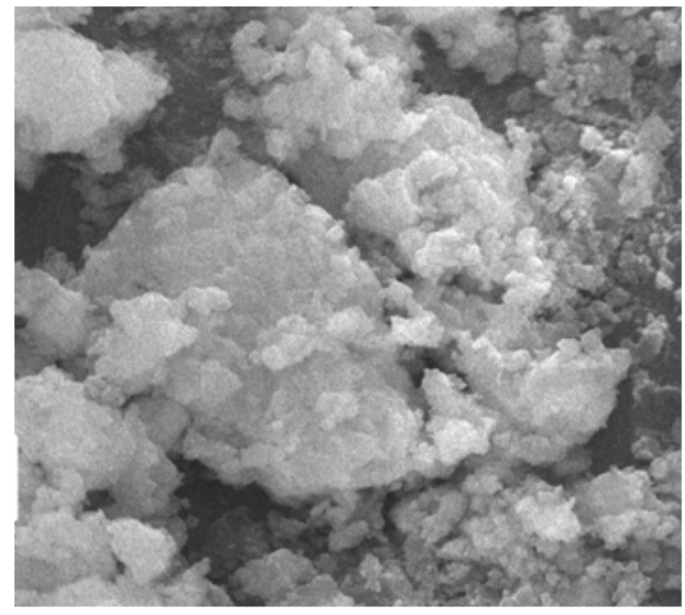
Figure 16. Foundry sand replacement in concrete (30%).